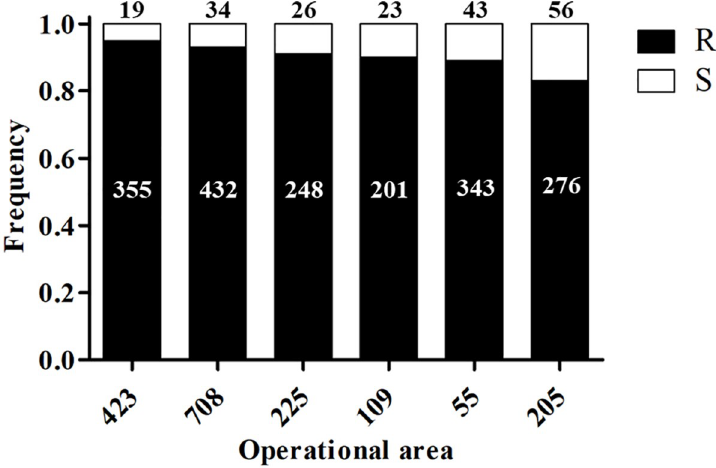
Fig 9. Frequencies of kdr -resistant and susceptible alleles of Cx . quinquefasciatus per area. There were no significant differences among areas ( P > 0.05). The numbers on bars refer to the numbers of mosquitoes’ alleles analyzed for each area: in black on top are the number of susceptible allele (S), and in white in black boxes are the number of kdr -resistant allele (R).